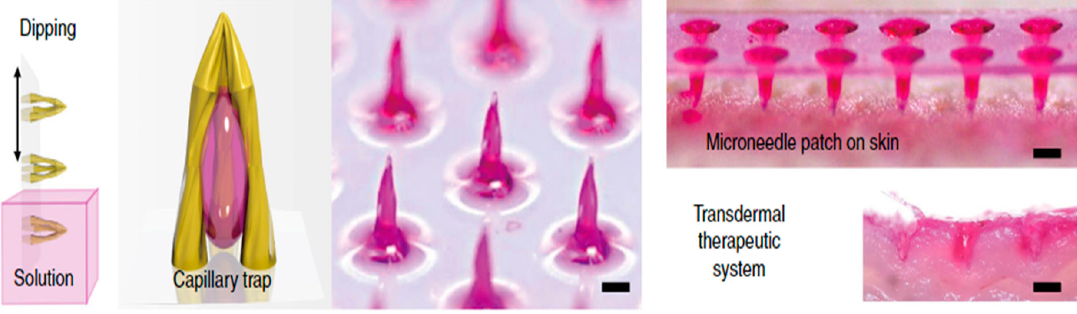
Figure 5. Merged-tip MN (adopted from [81]).